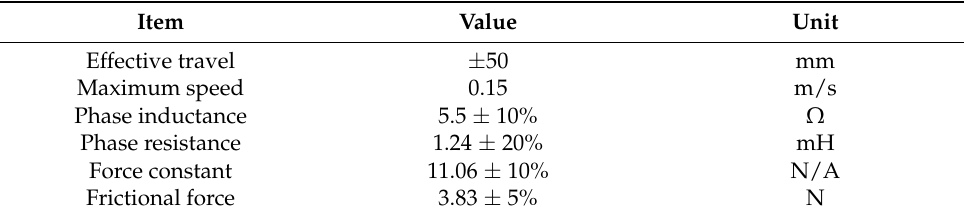
Figure 6. Test platform of coreless linear motion system. Table 4. Main parameters of motion